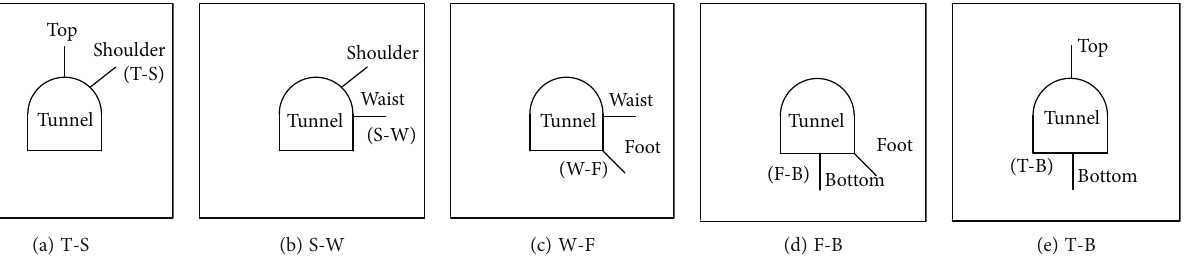
Figure 3: Di ff erent spacing between joints and tunnel.